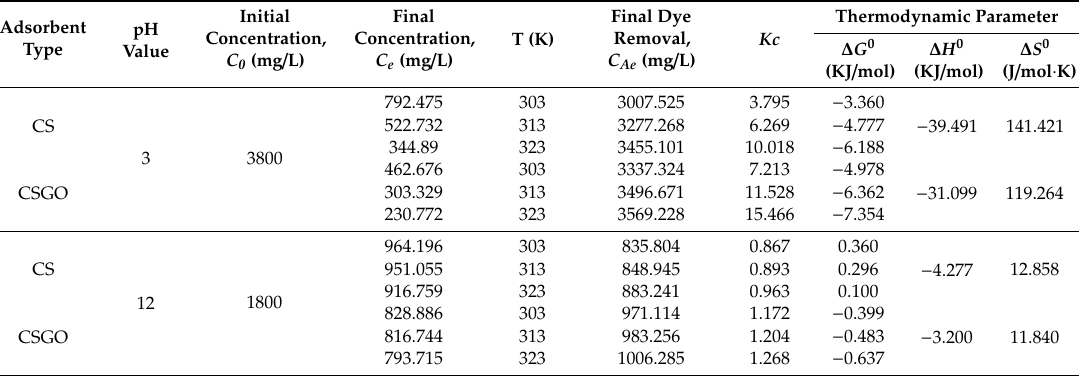
Figure 7. Relationship plots of ln K c vs. 1/T for determining the thermodynamic parameters under different test conditions: ( a ) at a pH of 12 and an initial RB221 concentration of 1800 mg/L and ( b ) at a pH of 3 and an initial RB221 concentration of 3800 mg/L ( ■ CS, ● CSGO). Table 2. Thermodynamic parameters for the adsorption processes of RB221 by di ff erent adsorbents (test conditions: a pH of 3 and an initial RB221 concentration of 3800 mg / L; a pH of 12 and an initial RB221 concentration of 1800 mg /